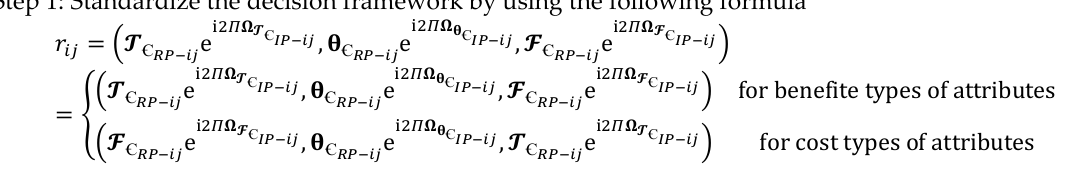
for cost types of attributes